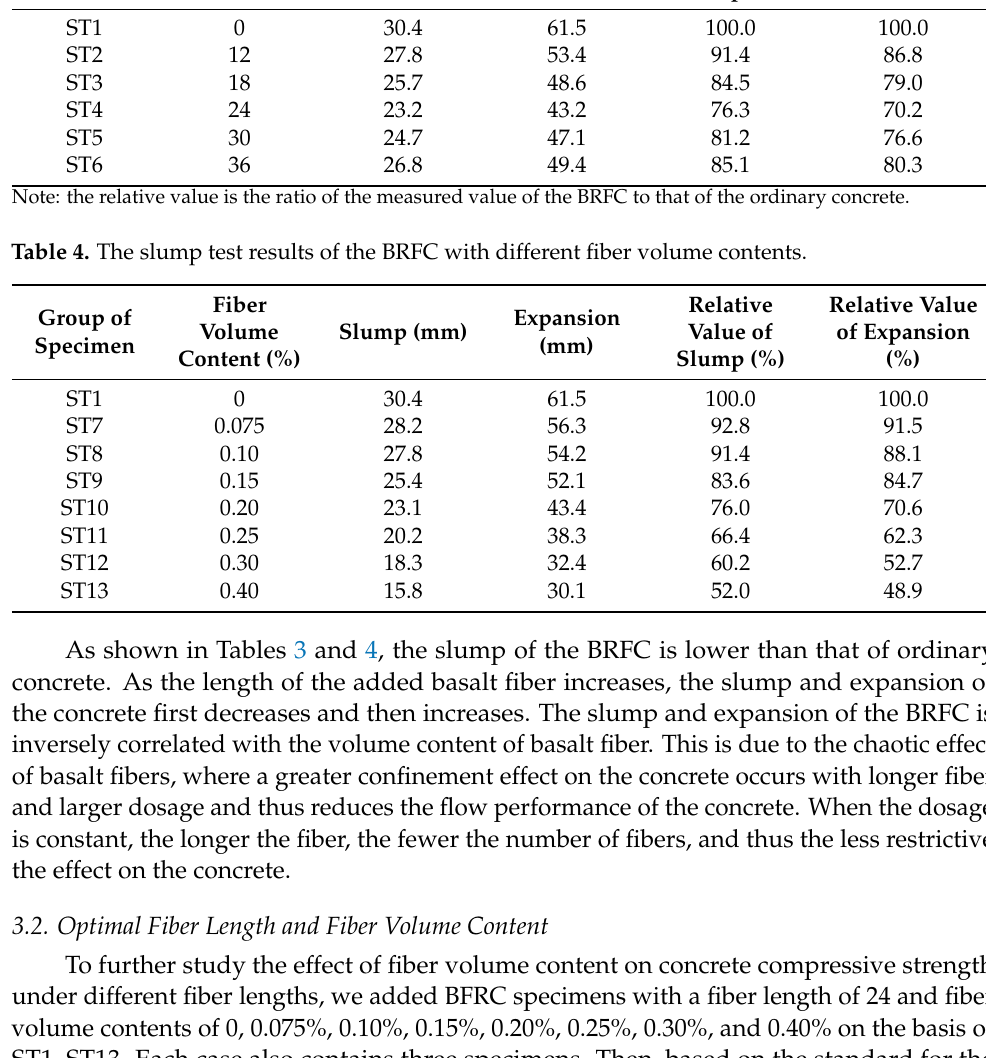
Table 3. The slump test results of the BRFC with different fiber lengths. Group of Specimen